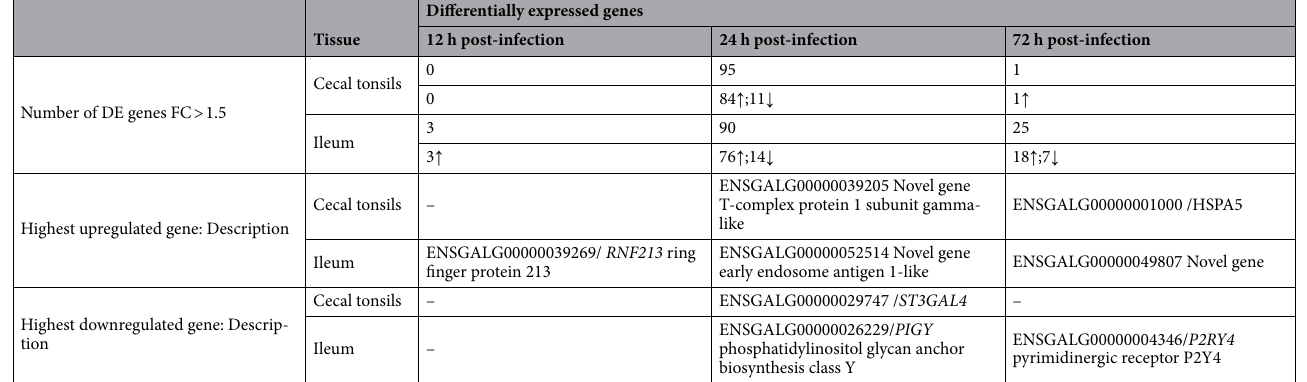
Table 1. Significant gene expression changes following influenza infection. Cecal tonsils, ileum. FC, fold change; ↑ , upregulated; ↓ ,